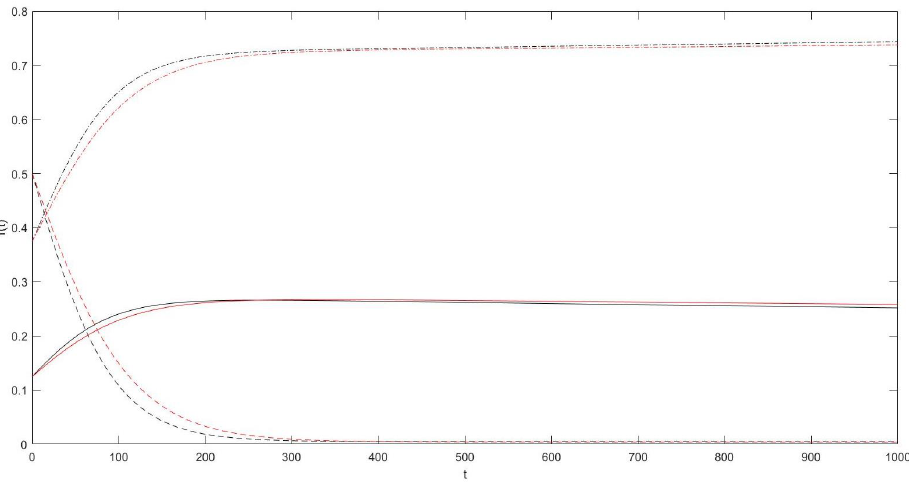
Figure 2. In black the solution for η = 3, in red the solution for η =